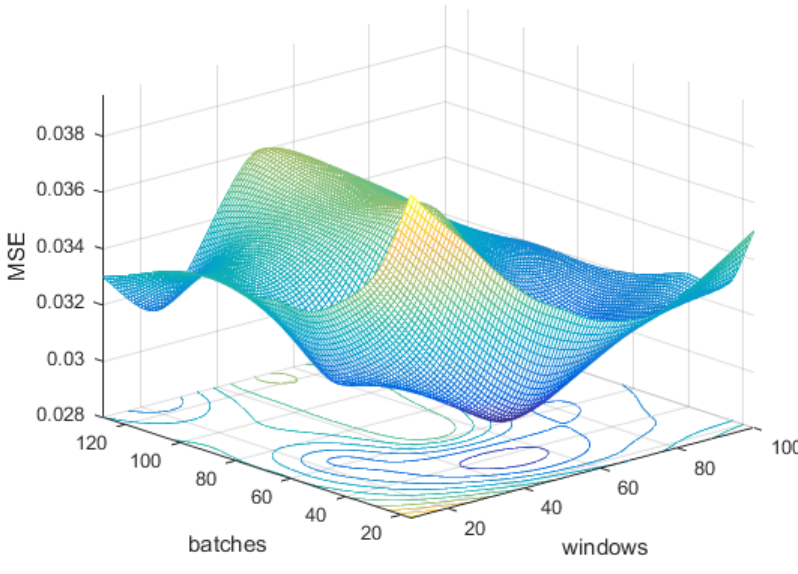
Figure 5. 3D fitting diagram of LSTM’s performance with different numbers of batches and